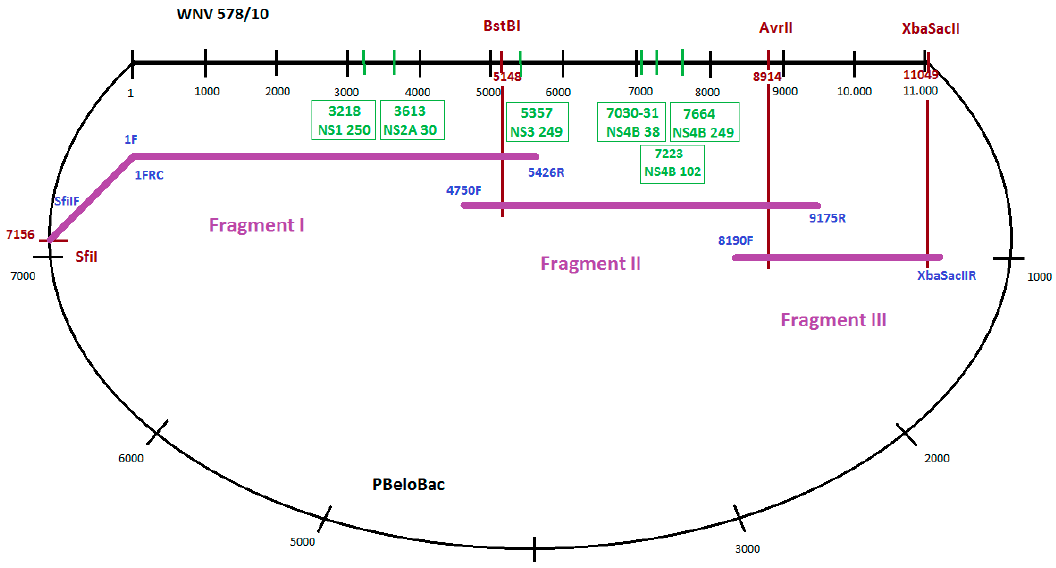
Figure 1. Cloning strategy for the WNV-578/10 genome and positions of the generated mutations. Black numbers represent nucleotide positions in WNV genome/PBeloBac plasmid genome. Red numbers indicate nucleotide positions of restriction enzyme cleavage sites in WNV genome. Green numbers in boxes represent nucleotide positions of inserted mutations. Names of used primers are in blue.